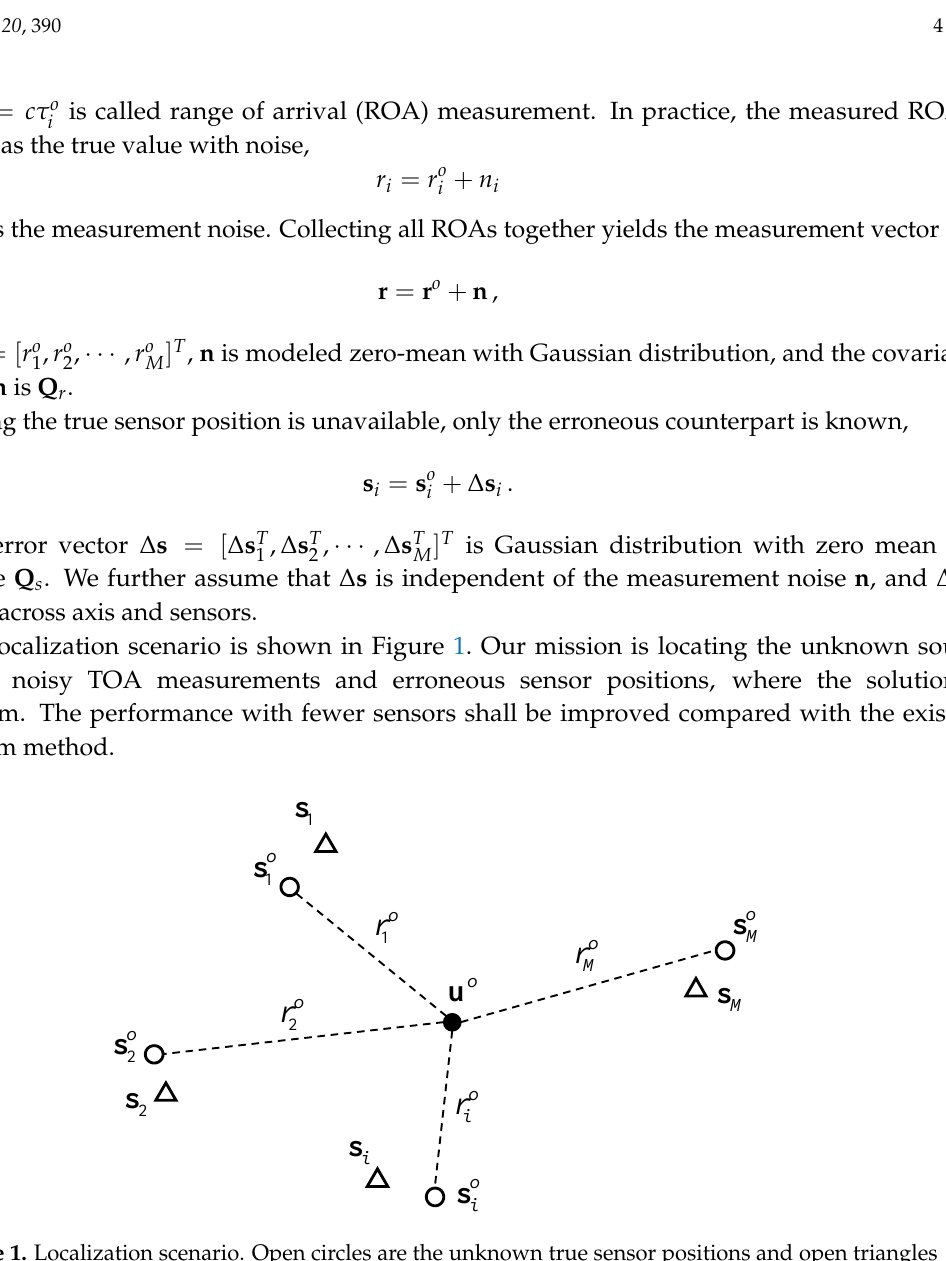
Figure 1. Localization scenario. Open circles are the unknown true sensor positions and open triangles represent the available imprecise sensor